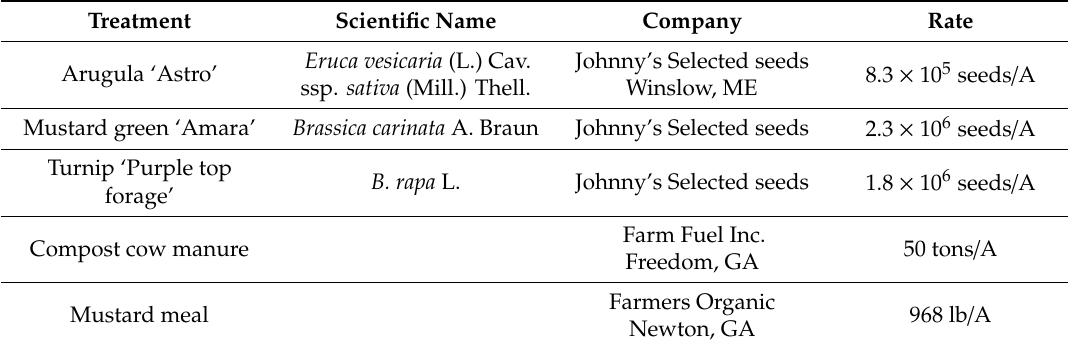
Table 4. Cover crops and organic inputs used in this